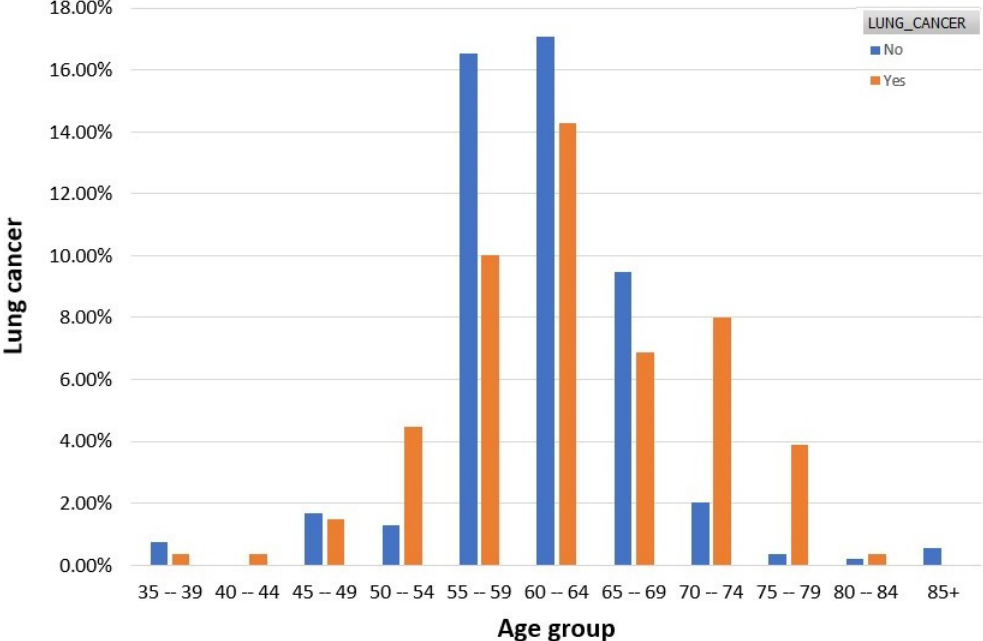
Figure 1. Participants distribution in the age groups in the balanced